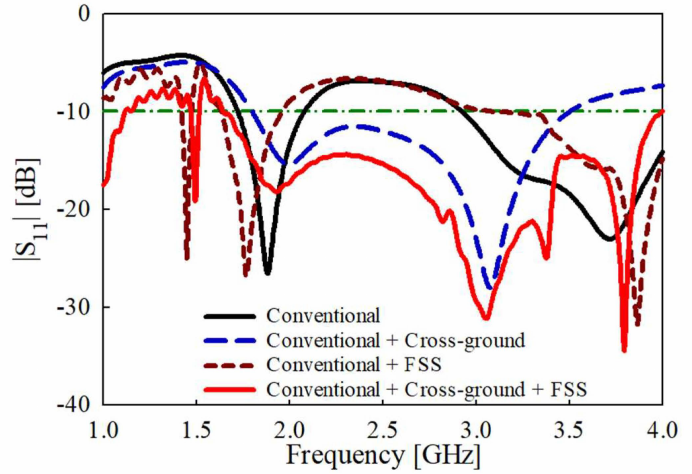
Figure 10. Simulated results of the input reflection coefficient